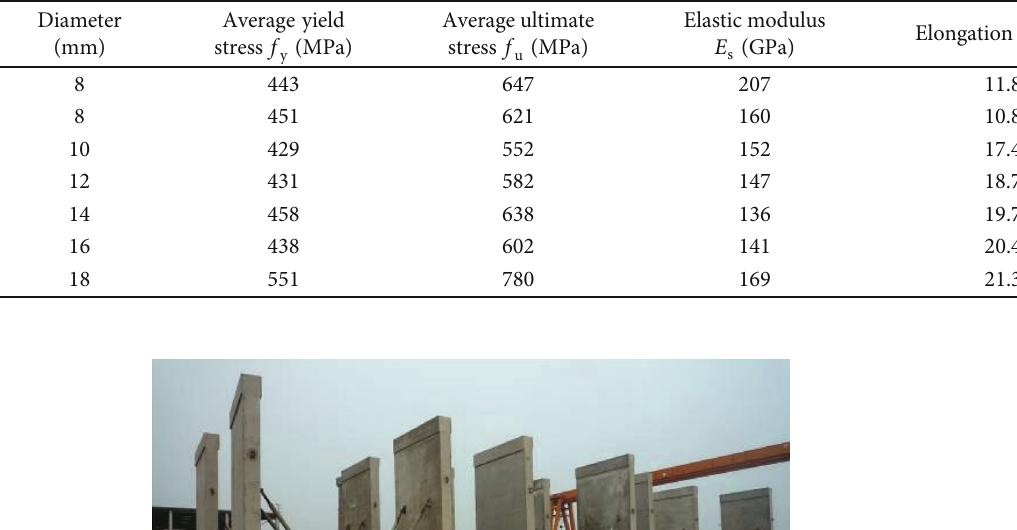
Table 2: Measurements of mechanical properties of steel.